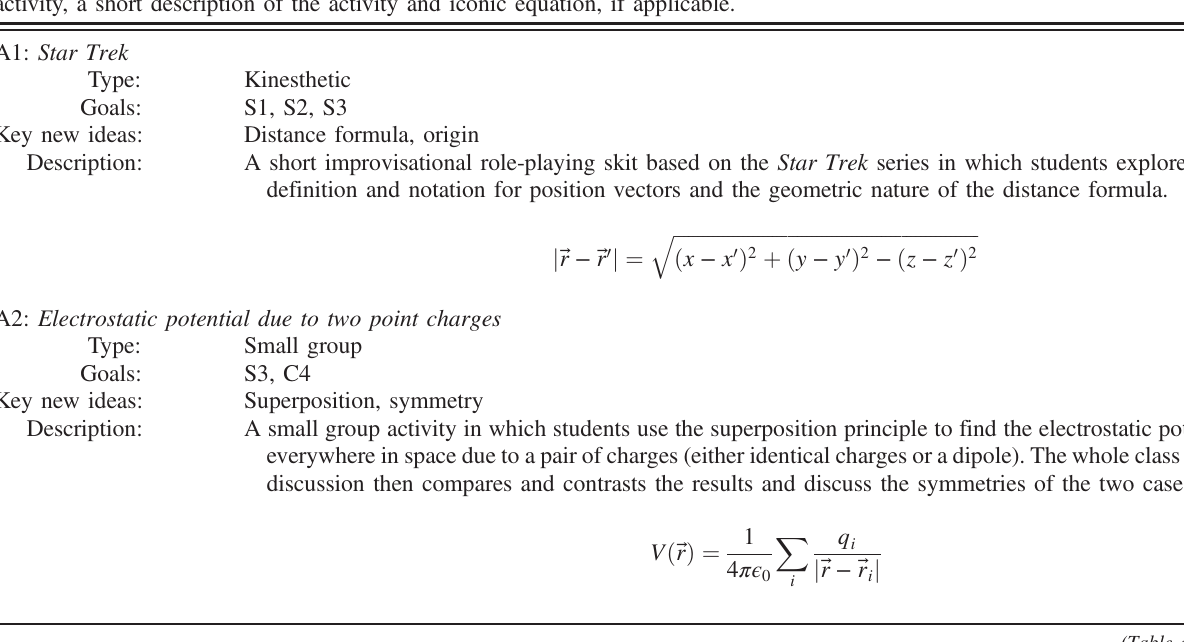
TABLE II. The activities of the ring cycle including: name, type of activity, learning goals addressed, key new ideas introduced in the activity, a short description of the activity and iconic equation, if